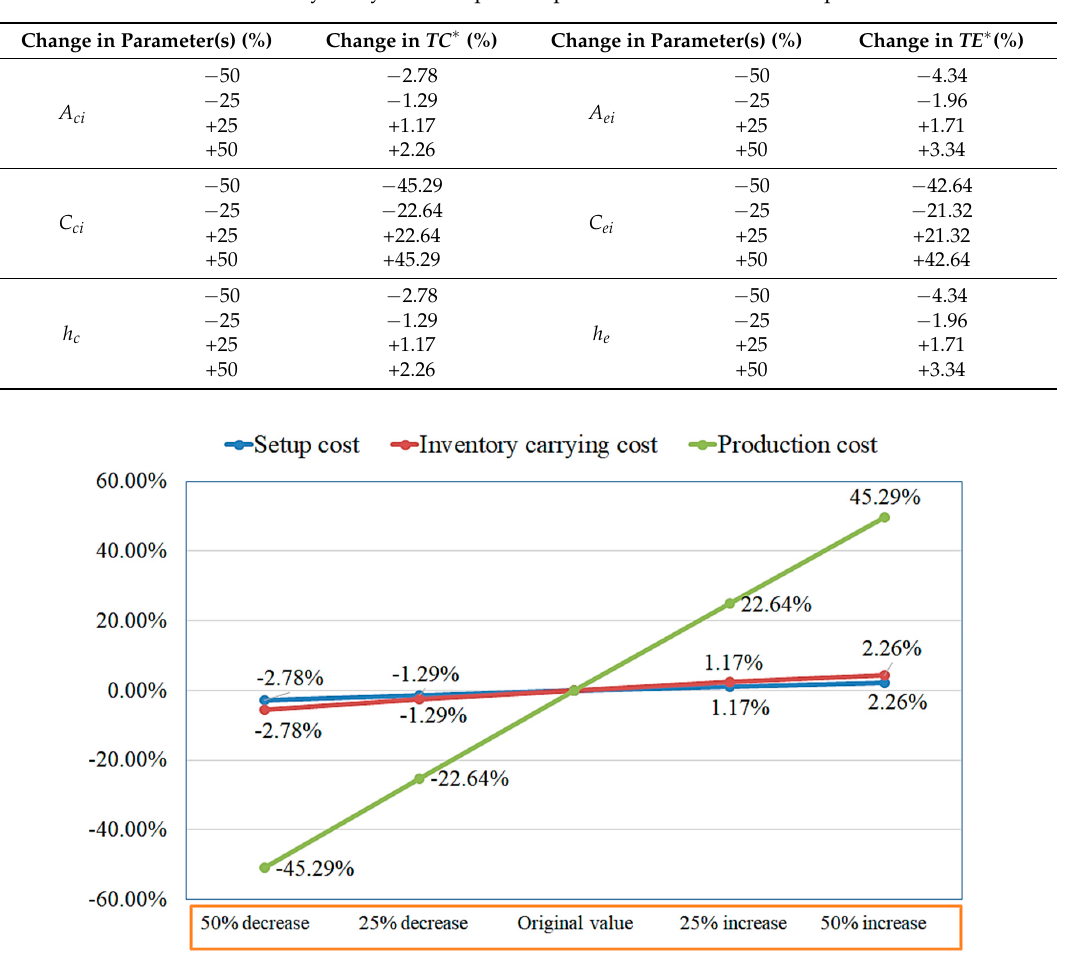
Table 7. Sensitivity analysis for important parameters of numerical experiment.